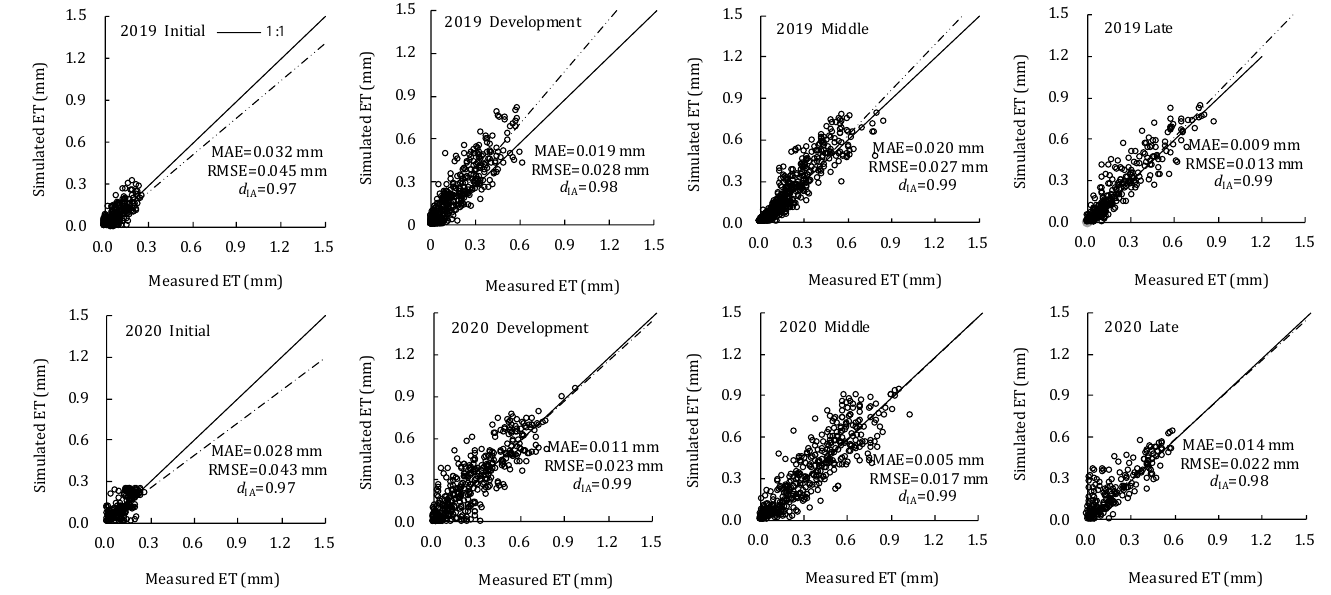
Figure 4. Comparison of measured and simulated hourly ET of greenhouse tomato at four growth stages in 2019 and 2020.